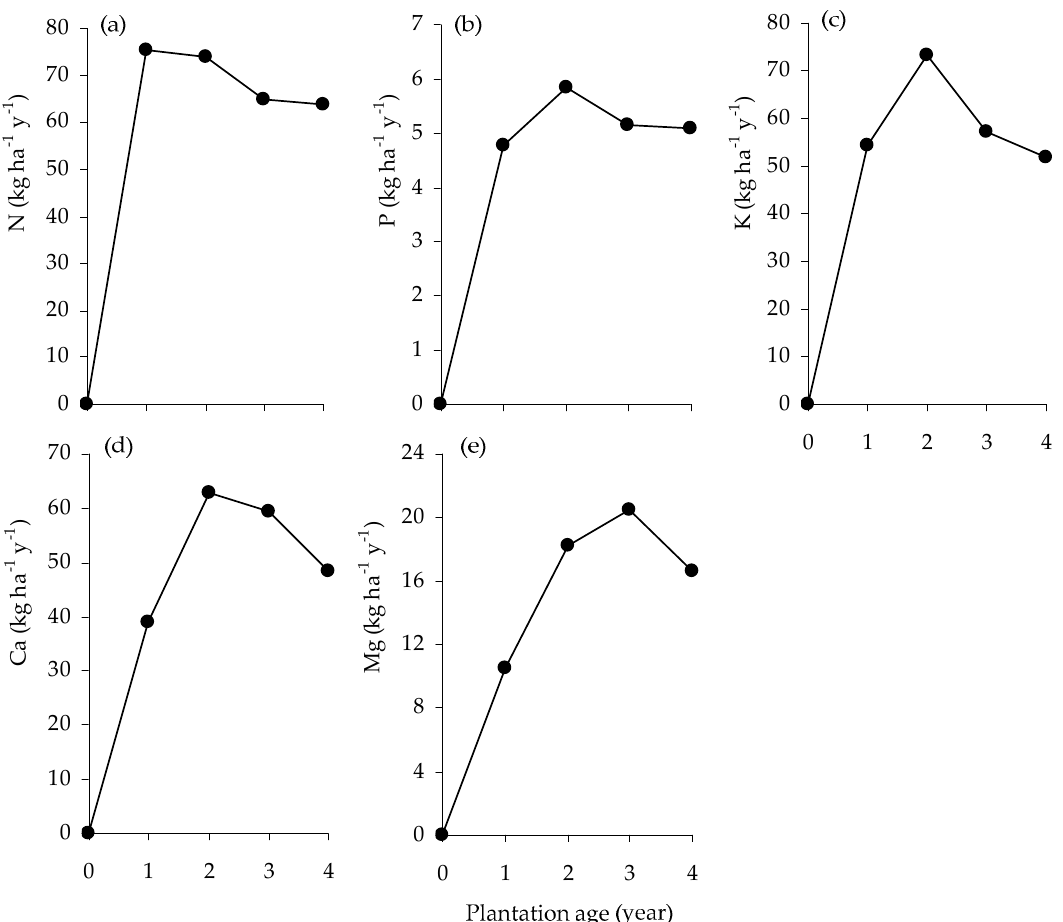
Figure 4. Mean annual rate of N ( a ), P ( b ), K ( c ), Ca ( d ) and Mg ( e ) accumulation (kg ha − 1 y − 1 ) in the standing biomass of E. pellita with plantation age.